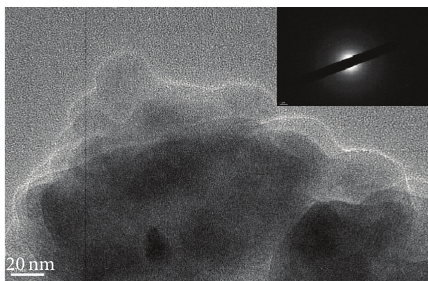
Figure 6: TEM image and SAED of char obtained from mixture of Japanese cedar wood meal/TiO 2 (1: 1 w/w) pyrolyzed at 800 ∘ C.